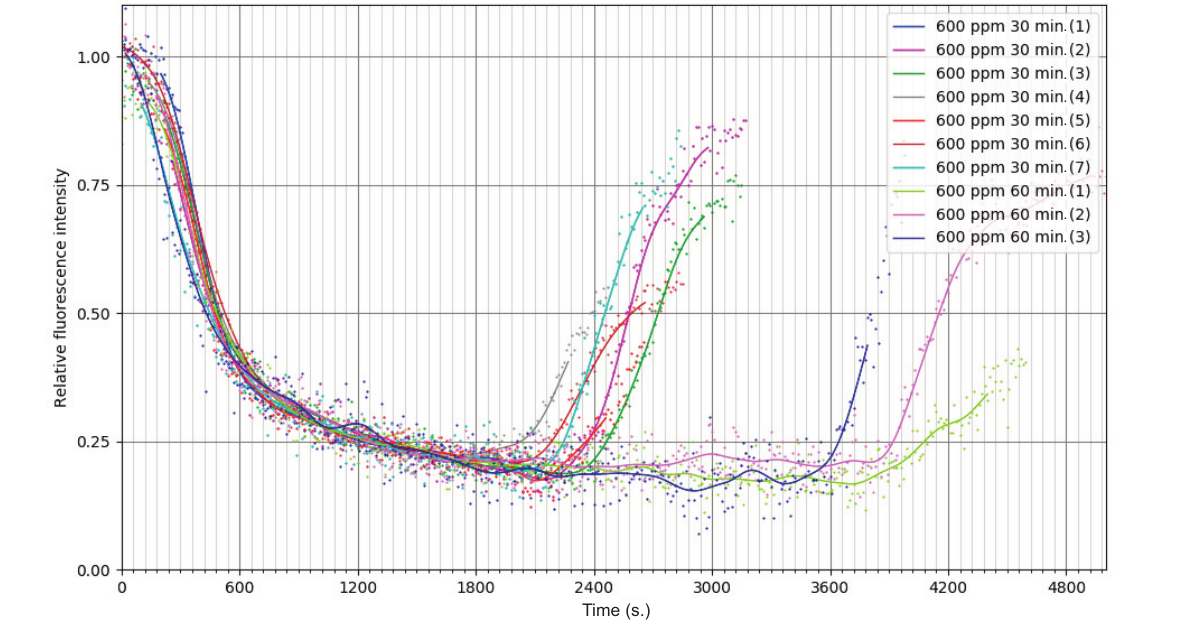
Fig. 6. Online measurement results of tryptophan fluorescence signal intensity of B. atrophaeus spore samples, which show an immediate increase in the signal level after lowering the concentration of HPV in a test volume.